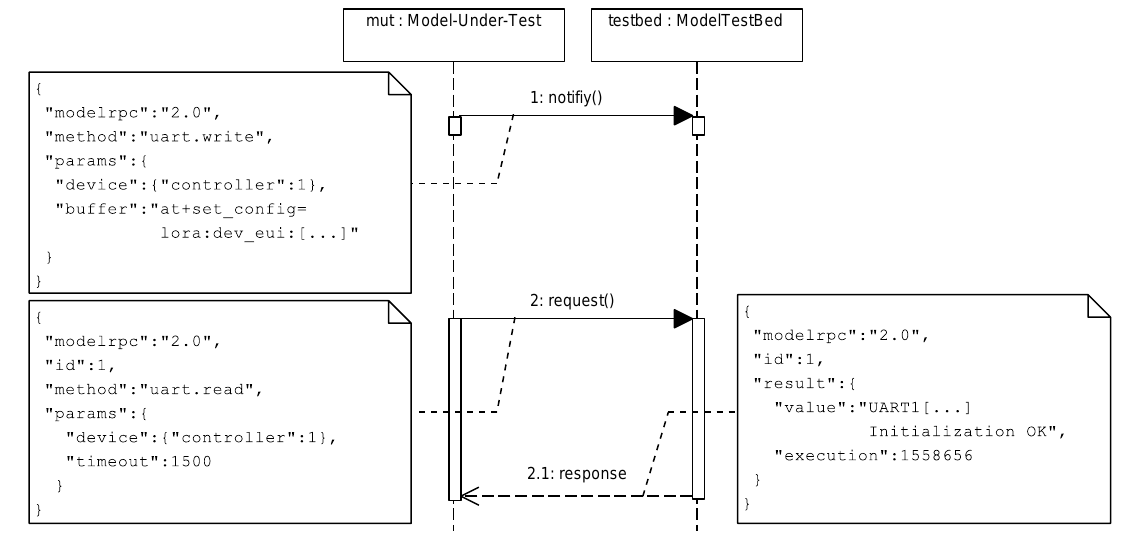
Figure 16. ModelRPC communication between model (client) and ModelTestBed (server) (UML 2.5 sequence diagram